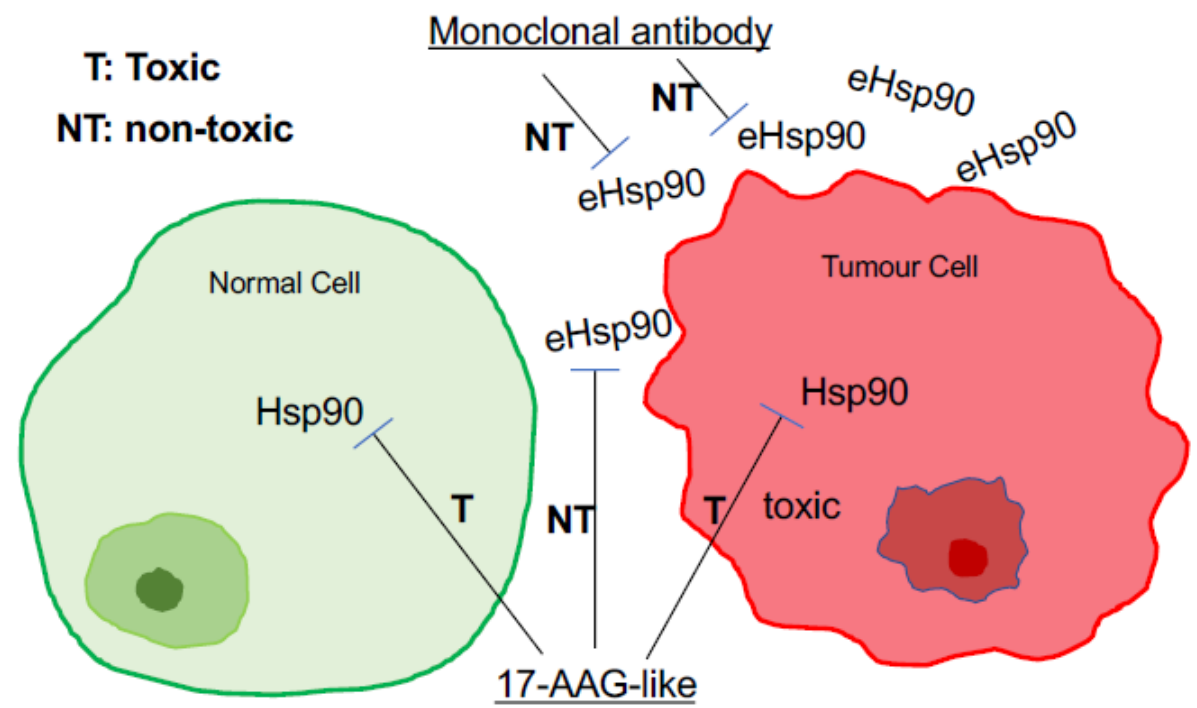
Figure 6. A major difference between targeting eHsp90 α and targeting intracellular Hsp90 in cancer. Cytotoxicity and lack of a clear therapeutic window under tolerable dosages have been the major hurdles for ATP-binding inhibitors of Hsp90, especially Hsp90 β , in cancer clinical trials. In contrast, selectively targeting eHsp90 α with membrane impermeable drug candidates has immerged as a new therapeutic strategy in cancer and